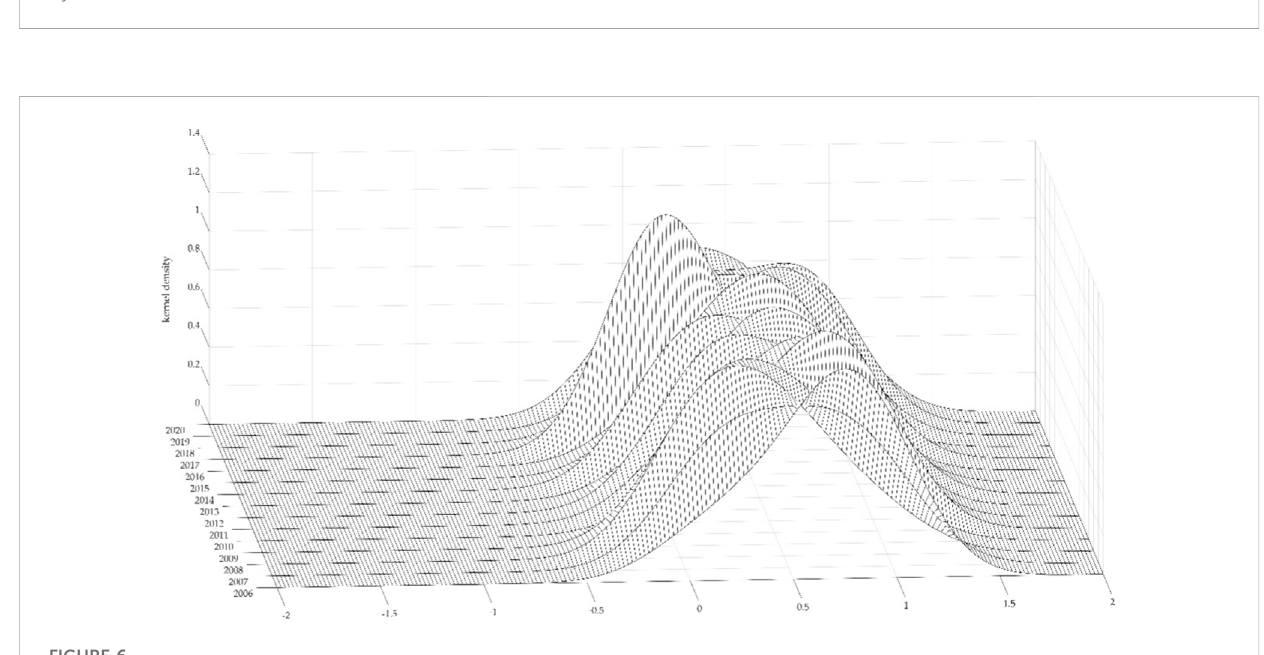
FIGURE 6 Dynamic evolution at the eastern